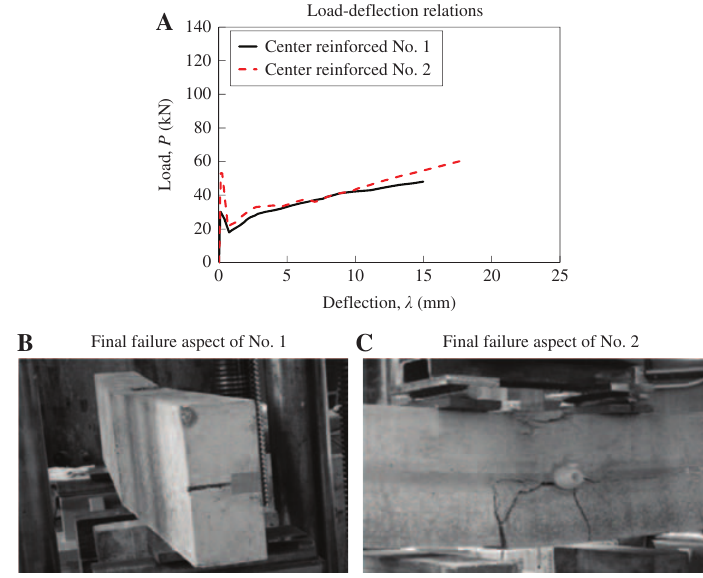
Figure 4 Center reinforced concrete beams.